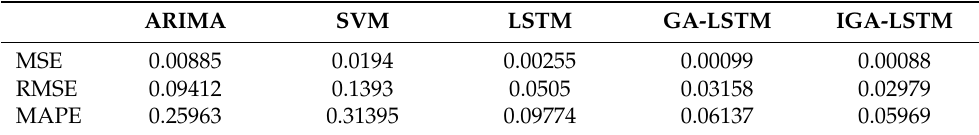
Table 7. Polyethylene and polypropylene results.